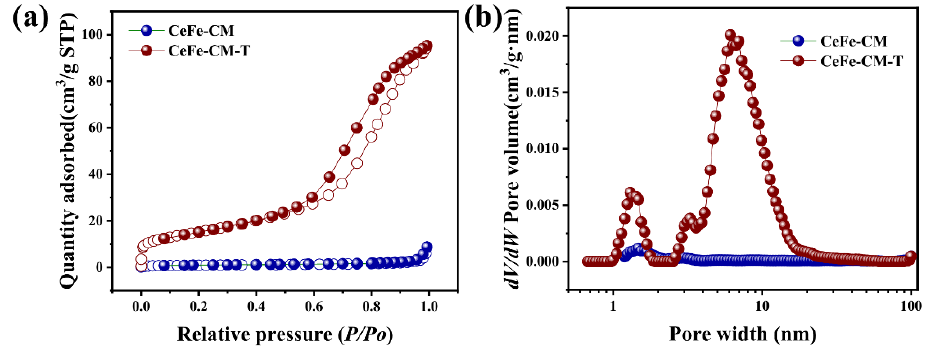
Figure 4. ( a ) N 2 adsorption–desorption curves and ( b ) pore distribution curves of CeFe-CM and CeFe-CM-T.